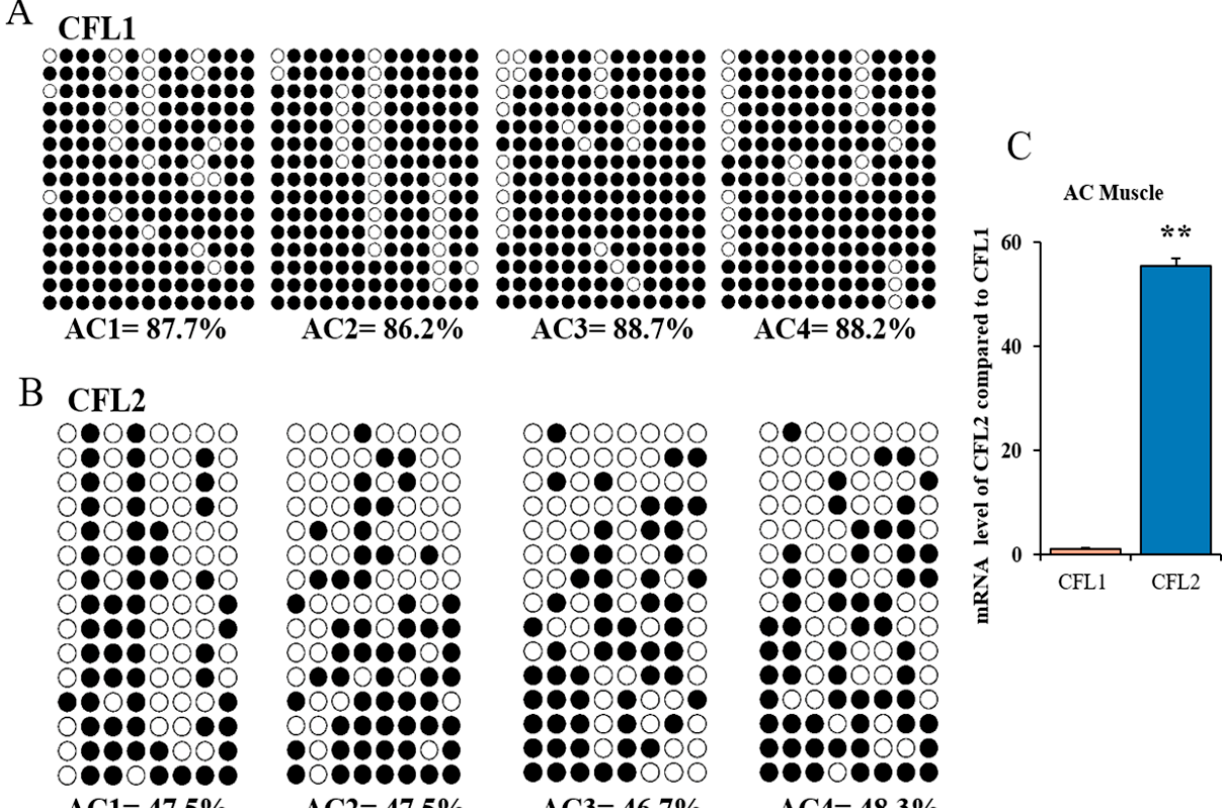
Figure 4. DNA methylation level of CFL1 and CFL2 gene promoters in adult cattle muscle tissues. DNA methylation patterns of CFL1 ( A ) and CFL2 ( B ) gene promoters in adult cattle muscle tissues (AC, n = 4) analyzed by BSP. Open circles show unmethylated CpGs and black circles methylated CpGs. mRNA expression level of the CFL2 gene compared to CFL1 was analyzed in muscle tissues ( C ). The mRNA expression level of CFL1 and CFL2 were normalized to GAPDH. The data represent the mean ± SE based on three independent experiments ( ** , p < 0.01).